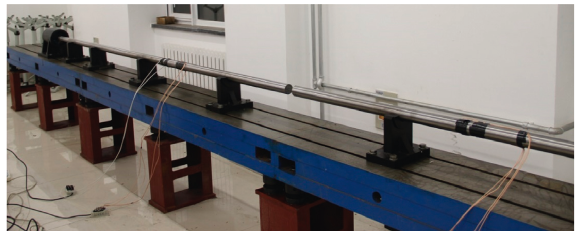
Figure 1: SHPB testing system.